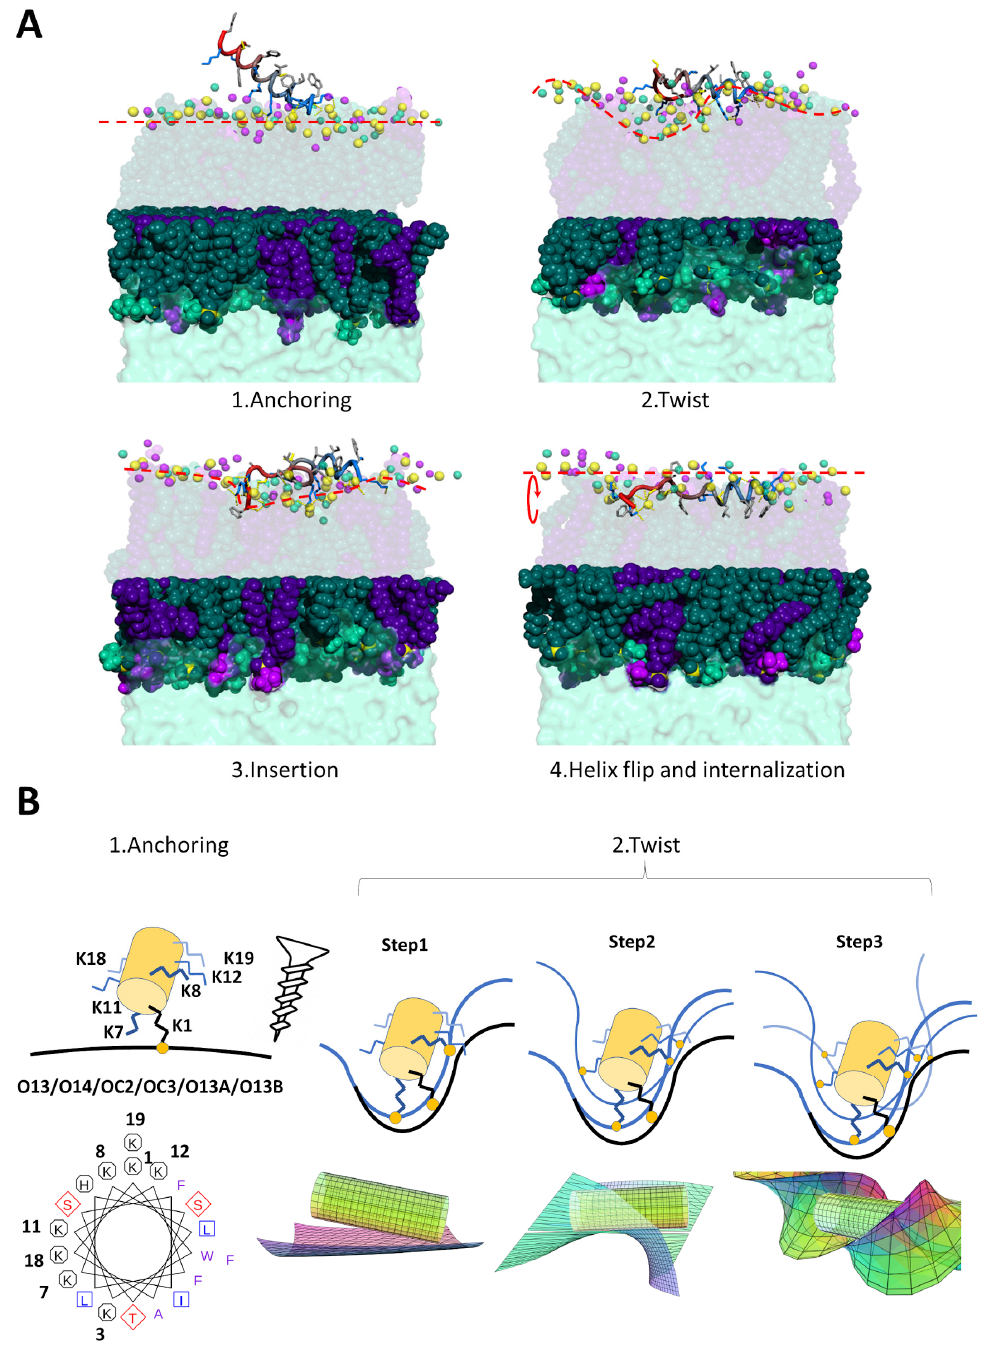
Figure 5. ( A ) Proposed mechanism of action of K11 peptide in four steps. The peptide first anchors to the membrane by the lysine residue in position 1 (anchoring) which can bind membrane oxygen atoms in a bidentate fashion. The peptide then twists the membrane (as described in panel B) thus allowing the insertion of terminal aromatic side chains. Finally, the peptide flips inside the bilayer. For color codes refer to the caption of Figure 4. ( B ) Mechanism by which K11 might exert a torque on the target membrane. Yellow circles represent oxygen atoms on the surface of the membrane and available for H-bonding or salt bridges with lysine side chains. The helix formed by K11 is represented as a cylinder. Lysine residues and membrane planes are represented in blue color whose intensity degrades with the distance from the observer. The torque is achieved in three subsequent steps, each rotating the membrane in the plane described by each couple of lysine residue. A geometrical representation of the effect on the membrane for each step is exemplified under each step. Image generated with the help of CalcPlot3D software